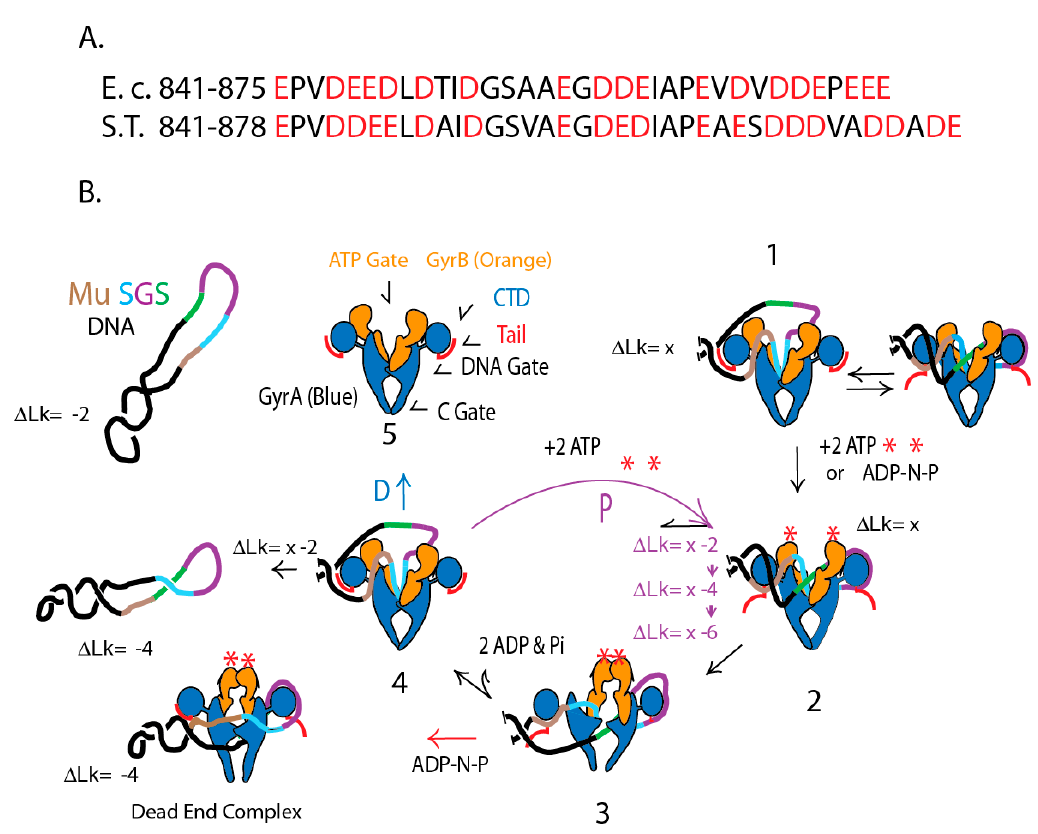
Figure 8. The GyrA red acidic tail controls of species-specific supercoiling. ( A ) Sequences of the GyrA C-terminal acidic amino acids (red) for E. coli and Salmonella Typhimurium. ( B ) Proposed mechanism to control supercoiling at different locations. Supercoiling is illustrated for a plasmid with a Mu SGS DNA binding site. The long arm (Brown) interacts with one gyrA pinwheel element, the gate segment (Aqua) folds into the upper chamber, and the right arm (Purple) interacts extensively with opposite pinwheel elements. The T segment (Green) passes through the open DNA gate during strand transfer. See text for step